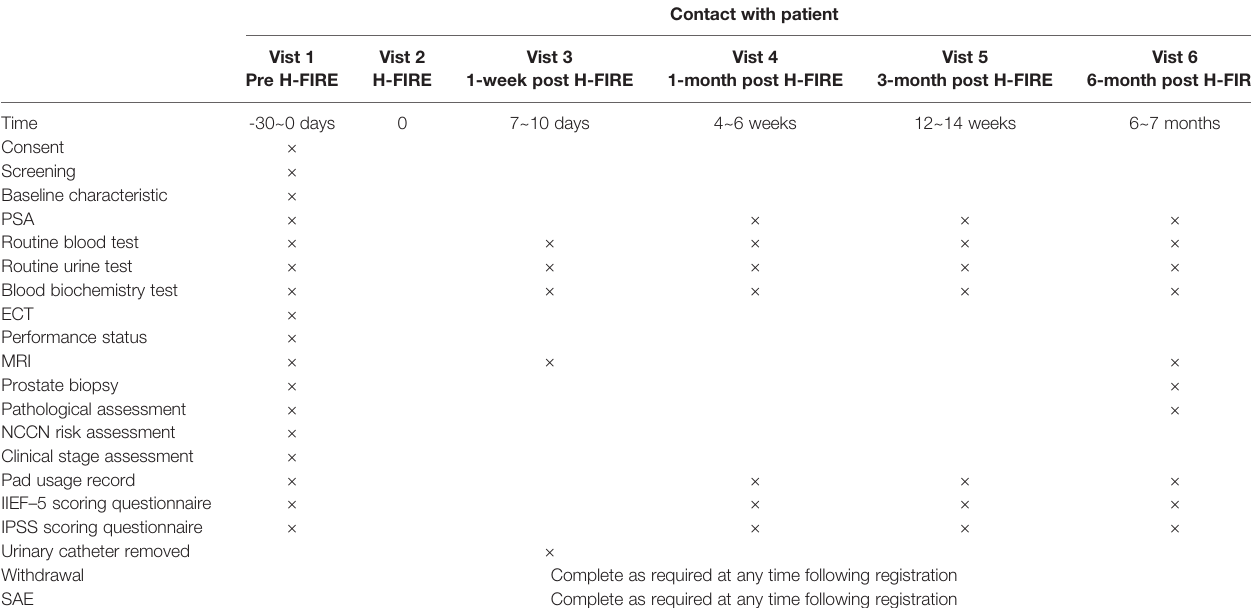
TABLE 2 | Participant timeline in the